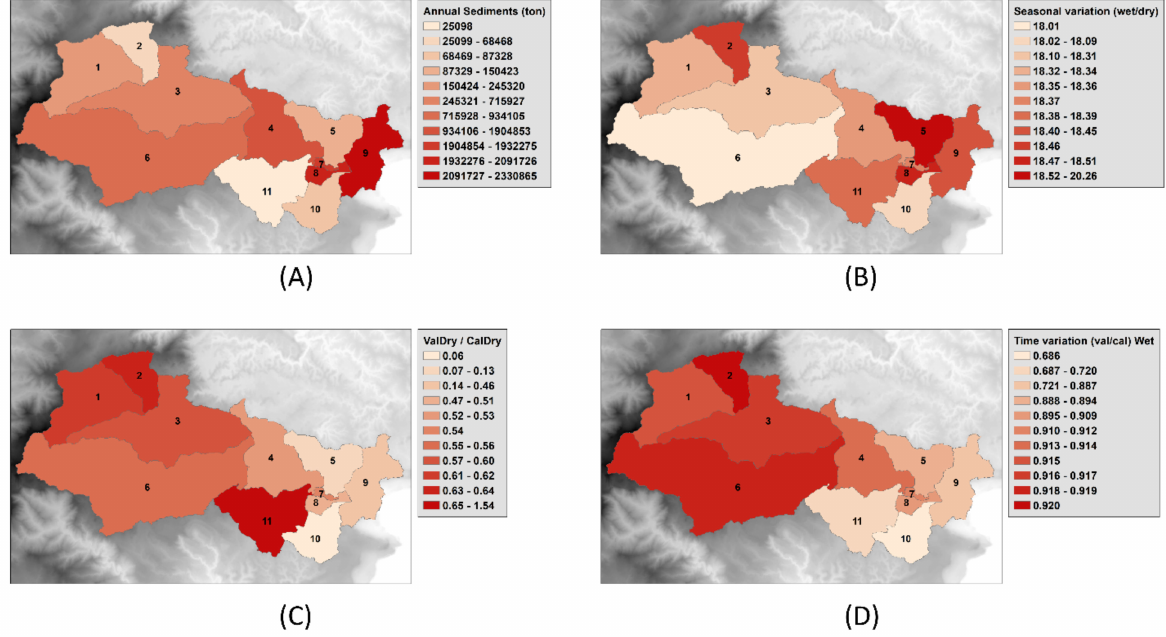
Figure 11. Sediment contribution maps. ( A ) Average annual total sediments, ( B ) seasonal variation (ratio of wet to dry), ( C ) time variation (ratio of validation to calibration periods) for the dry season, and ( D ) time variation (ratio of validation to